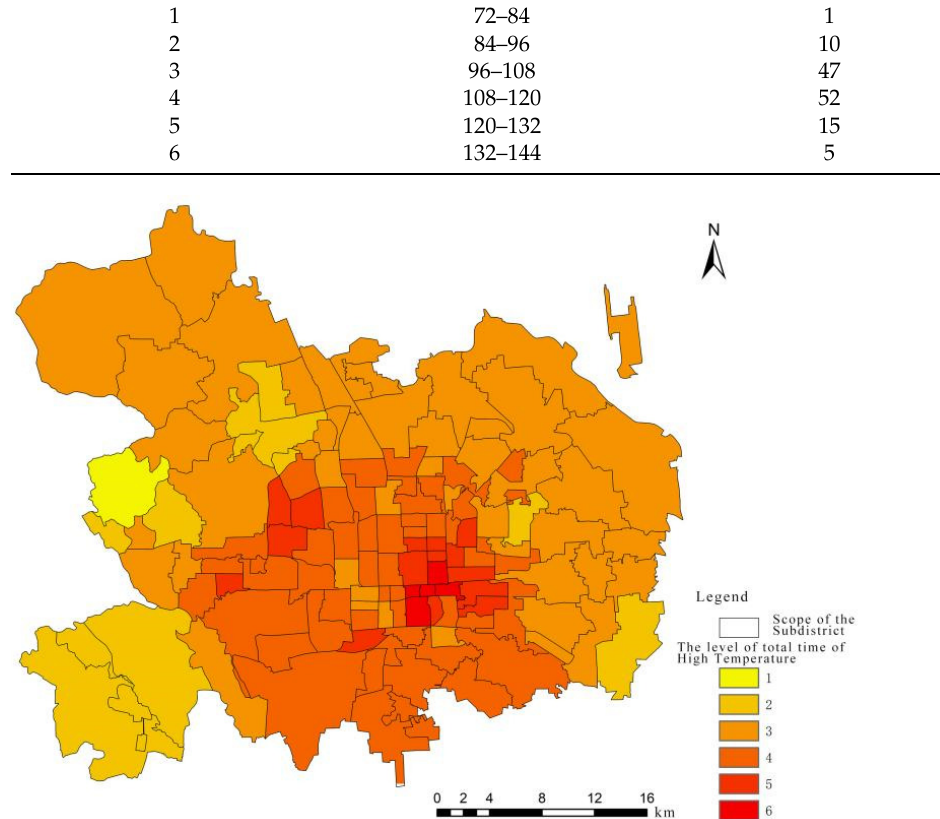
Figure 3. Heat duration distribution in the central urban area of Beijing.